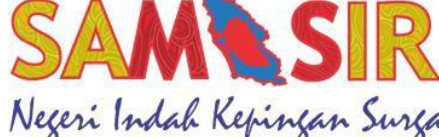
Figure 1. Samosir Regency Tourism